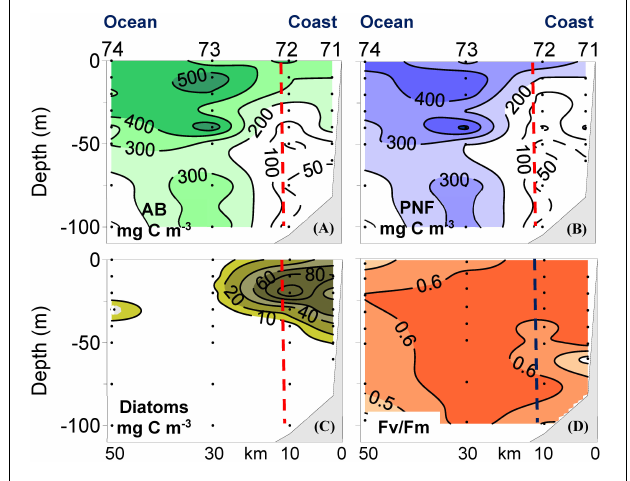
FIGURE 1 | Vertical distributions of (A) total autotrophic biomass (AB), (B) biomass of pigmented nanoflagellates (PNF), (C) biomass of diatoms, and (D) variable fluorescence to maximum in vivo fluorescence ratio (Fv/Fm, dimensionless) at 1 selected transect sampled during the spring 1991 in the NW Iberian upwelling. The vertical dashed line separates coastal and oceanic domains. Redrawn from Crespo et al. (2011).